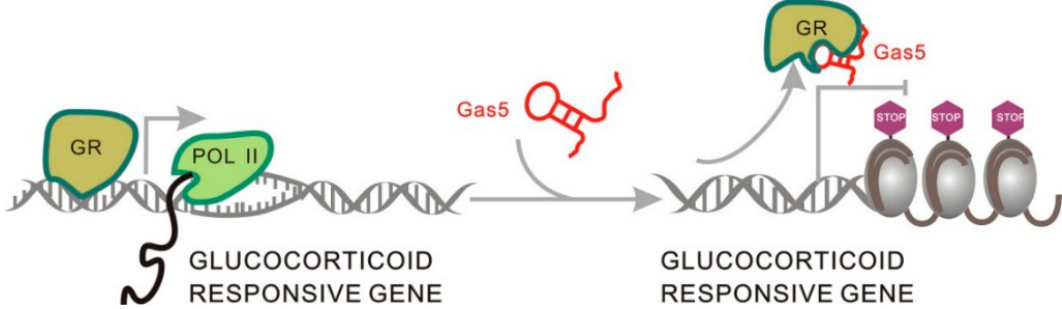
Figure 6. The role of Gas5 secondary structure transformation in glucocorticoid signal transduction. Gas5 serves as a decoy for GR and removes it from the signaling pathway by changing its secondary structure. POL: Polymerase.